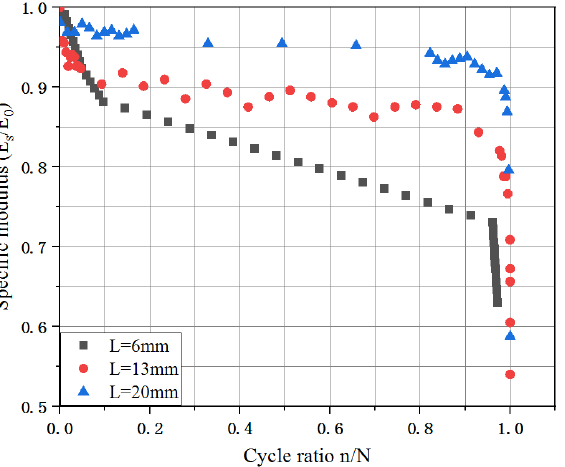
Figure 11. The decaying response of elastic modulus with the number of cycles. Caepinteri [7] employed DIC to analyze the latent critical crack path of unnotched concrete specimens under cyclic loading, and established the function of stress intensity factor (K) for unnotched concrete, according to Equation (5), which slightly differed from per-notched specimens [22]: